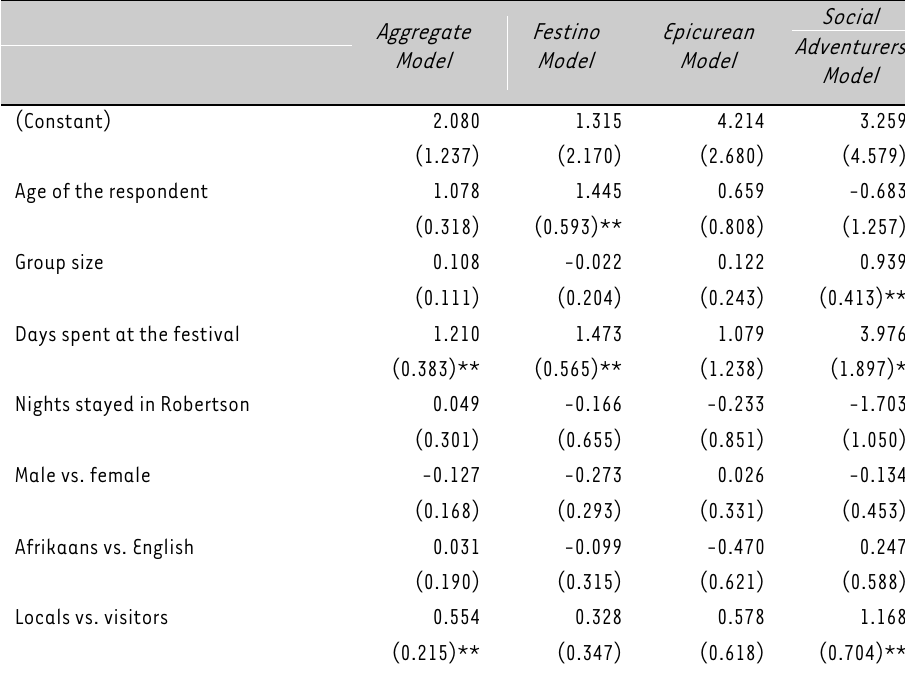
TABLE 4: Regression